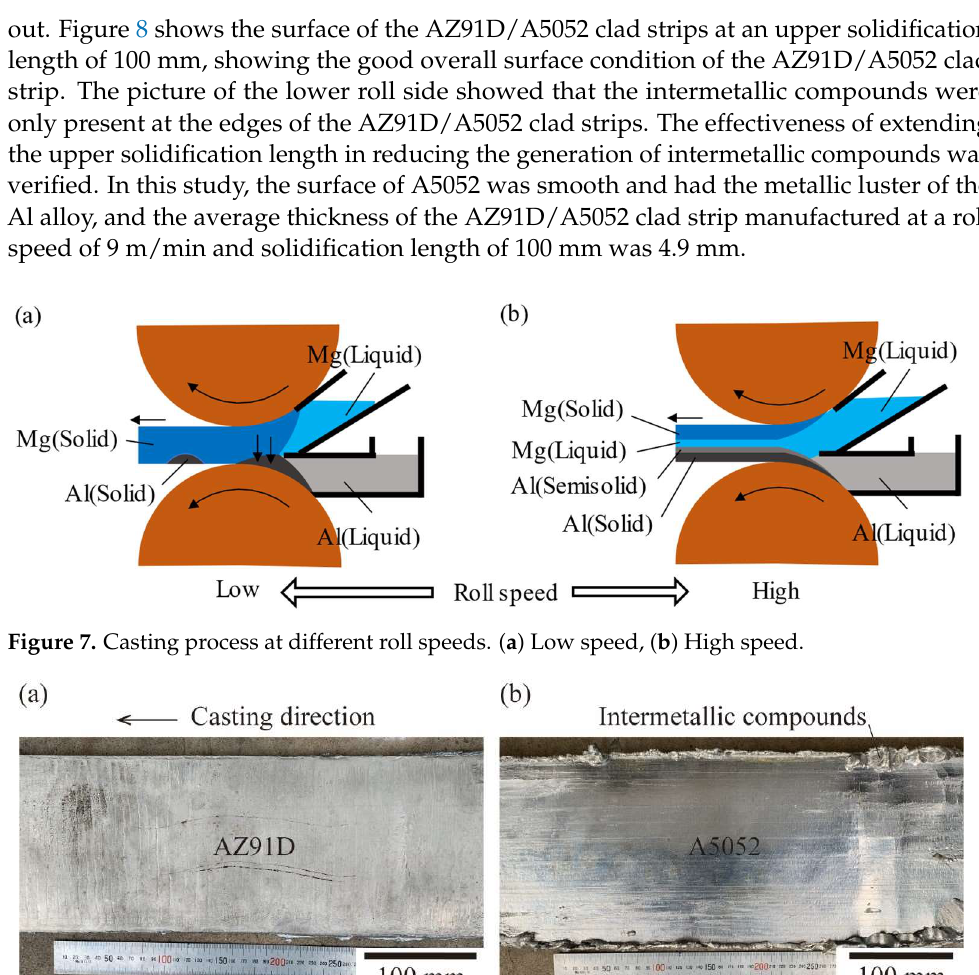
Figure 7. Casting process at different roll speeds. ( a ) Low speed, ( b ) High speed.